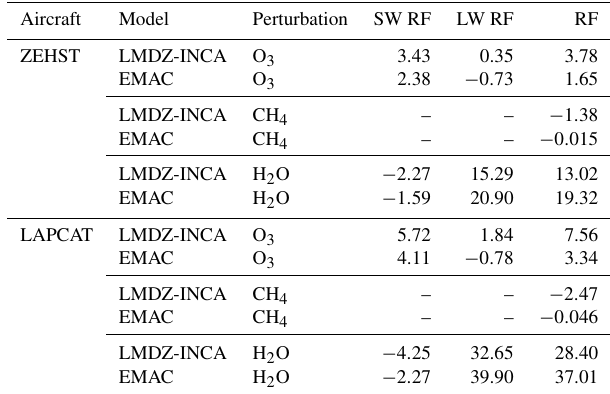
Table 6. Short- and longwave contributions (respectively, SW and LW) to radiative forcing (RF) in mWm − 2